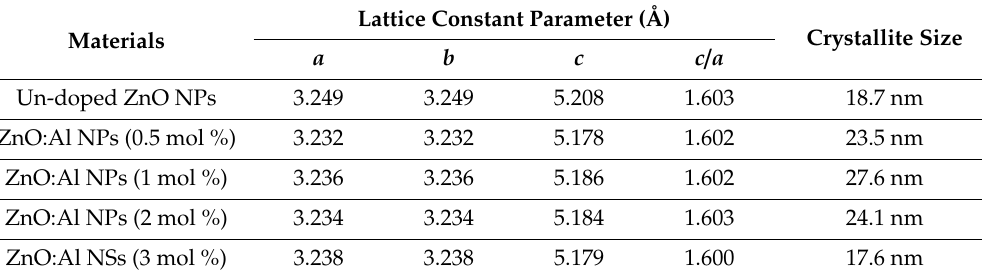
Figure 1. X-ray diffraction of pure and Al doped ZnO NSs ( A ), magnified area of (1, 0, 0) plane ( B ). Table 1. Lattice constant parameters and crystallite size of pure and Al doped ZnO NPs.